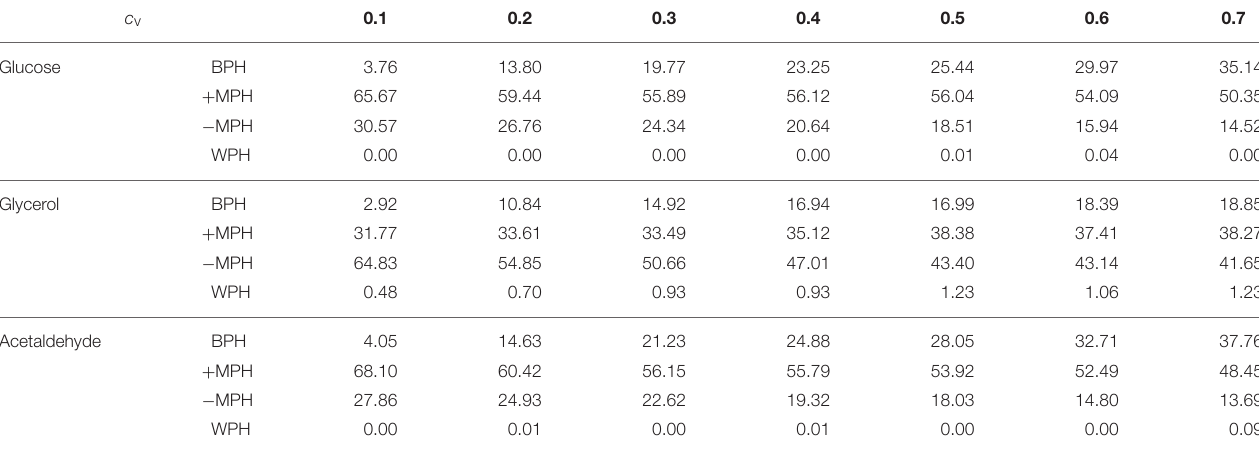
TABLE 1 | Percentage of occurrence of the four types of inheritance for the glucose, glycerol and acetaldehyde fluxes over the range of c v values when E tot is free.